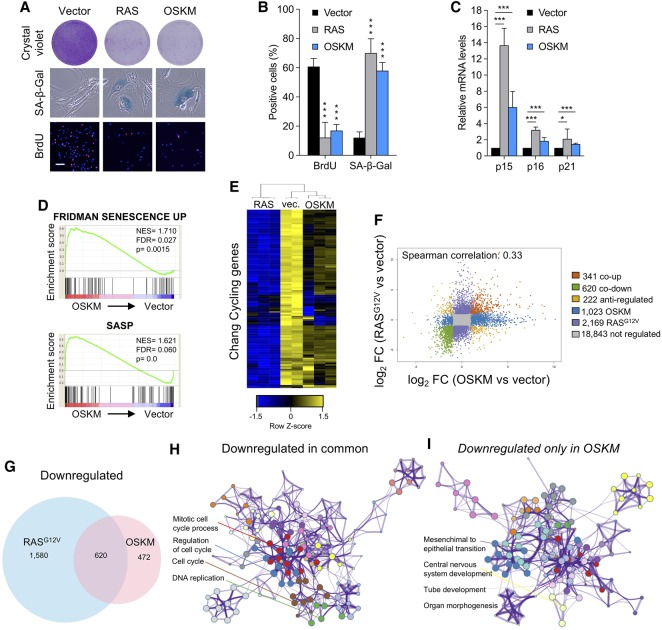
Expression of OSKM results in the induction of a characteristic senescence program in IMR90 human fibroblasts. (A) Senescence markers in IMR90 fibroblasts infected with control (vector), a polycistronic vector expressing OSKM or RAS. At 12 d after infection, senescence was assayed by crystal violet staining (top), senescence-associated β-galactosidase (SA-β-Gal) activity (middle), and BrdU incorporation after an 18-h pulse (bottom). Bar, 100 µM. (B) Quantification of BrdU and SA-β-Gal-positive cells after infection with the indicated vectors. (***) P < 0.001. (C) Quantitative RT–PCR (qRT–PCR) showing the mRNA expression levels of CDKN2B (encoding p15INK4b), CDKN2A (p16INK4a), and CDKN1A (p21CIP1) after infection with the indicated vectors. (*) P < 0.05; (***) P < 0.001. (D) Gene set enrichment analysis (GSEA) showing enrichment of signatures associated with senescence and the SASP in OSKM versus vector-expressing IMR90 cells. (NES) Normalized enrichment score. (E) Heat map showing gene expression of cell cycle genes (Chang et al. 2004) for IMR90 cells infected with vector, RAS, and OSKM. Log2 expression values (rlog) were row-normalized using Z-scores, and only genes that have higher expression in RAS or OSKM compared with vector are shown in the heat map. Both genes and samples were clustered using hierarchical clustering. (F) Scatter plot showing log2 fold change (FC) in gene expression between RAS versus vector and OSKM versus vector. Genes changing (false discovery rate [FDR] < 0.05; log2 fold change < −1 or log2 fold change > 1) are shown in color. (G) Venn diagram showing common down-regulated genes between RAS versus vector and OSKM versus vector. Down-regulated genes were defined as those with log2 fold change < −1 and FDR < 0.05. (H,I) Gene ontology (GO) term analysis of common genes down-regulated upon OSKM- and RAS-induced senescence (H) or down-regulated only in OSKM-induced senescence (I). First, for each senescence type, genes differentially regulated compared with control (vector) by log2 fold change < −1 (P < 0.05) were selected. Next, common genes were uploaded to the online bioinformatics database Metascape (http://metascape.org) for GO term detection and clustering. Same-colored dots fall into a function category similar to the given title. Only statistically significant categories (P < 0.05) are shown.